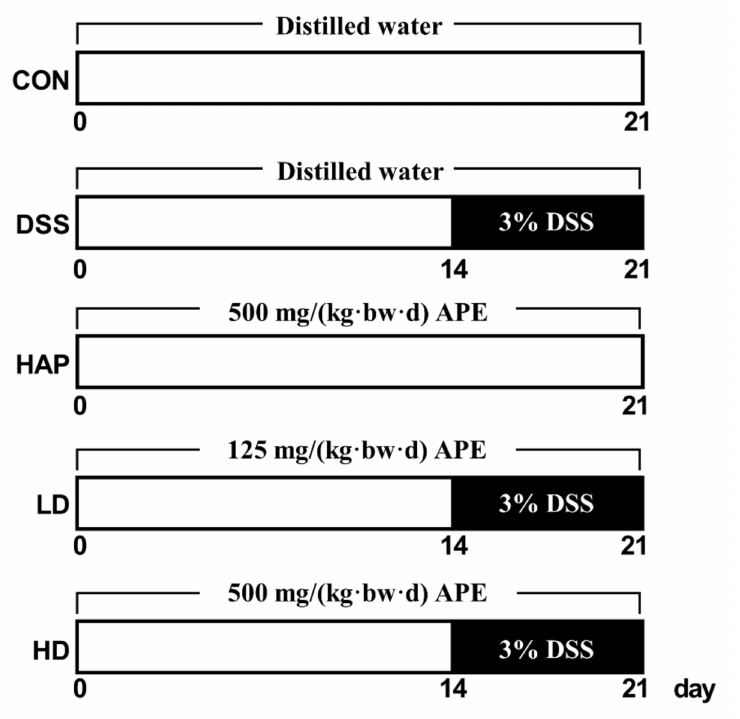
Figure 1. Diagram of study design. APE: apple polyphenols extract. CON: control group. DSS: 3% DSS (dextran sulfate sodium) model group. HAP: 500 mg/(kg · bw · d) APE group. LD: 125 mg/(kg · bw · d) APE + 3% DSS group. HD: 500 mg/(kg · bw · d) APE + 3% DSS